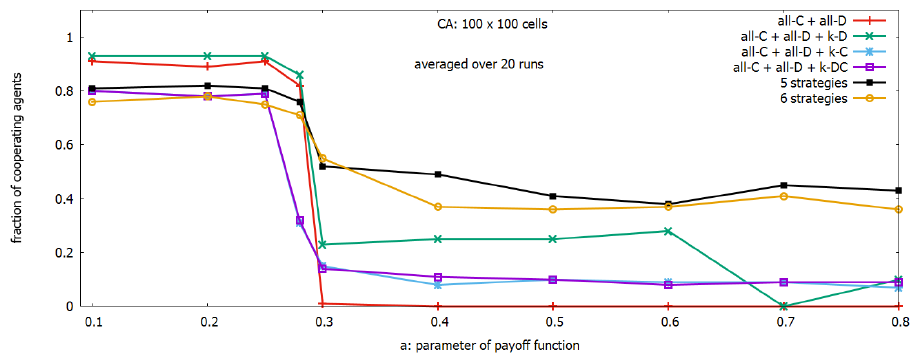
Figure 3. Fraction of cooperating agents with 6 different subsets of strategies as a function of the parameter a